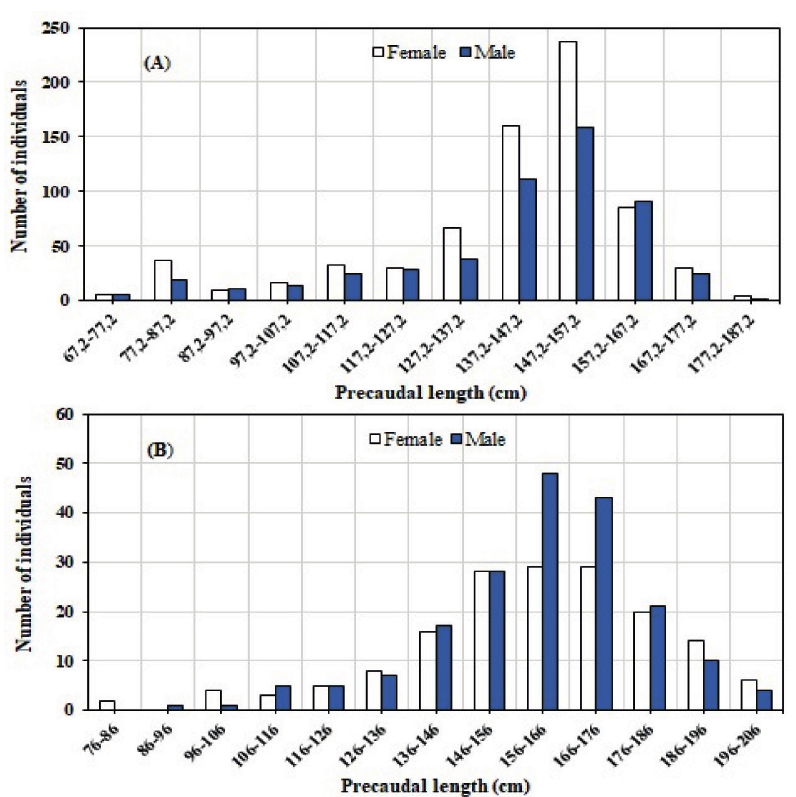
FIGURE 1 | Composition of sizes of male and female thresher sharks Alopias pelagicus ( A ) and A. superciliosus ( B ) landed in the town of Playita Mia, Manta